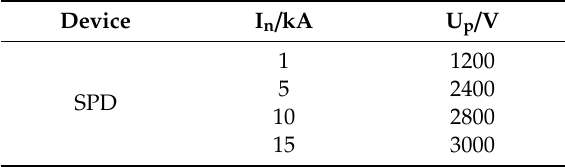
Table 2. Volt-ampere characteristics of a surge protective device (SPD).